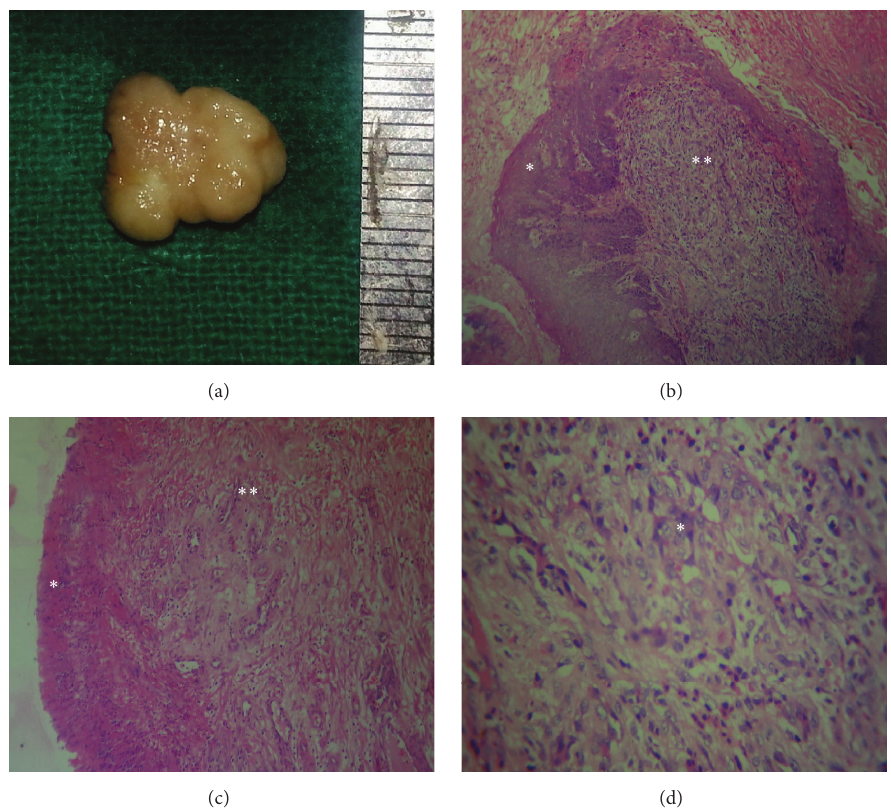
Figure 1: Case 1 description: (a) gross specimen; (b) low power view showing hyperplastic parakeratinized epithelium ( ∗ ) and underlying cellular stroma ( ∗∗ ) (H&E, 100x); (c) low power view showing fibrinopurulent membrane ( ∗ ) and underlying cellular stroma showing few proliferating capillaries ( ∗∗ ) (H&E, 100x); (d) high power view showing dense aggregation of plump endothelial cells ( ∗ ) with little evidence of lumen formation (H&E, 400x). Table 1: Clinical profile of the four cases of pyogenic granuloma. Sl. number Age Gender Site Size Histopathological category 1-2cm Cellular phase 1-2cm Capillary phase, LCH type 1-2cm Involutionary